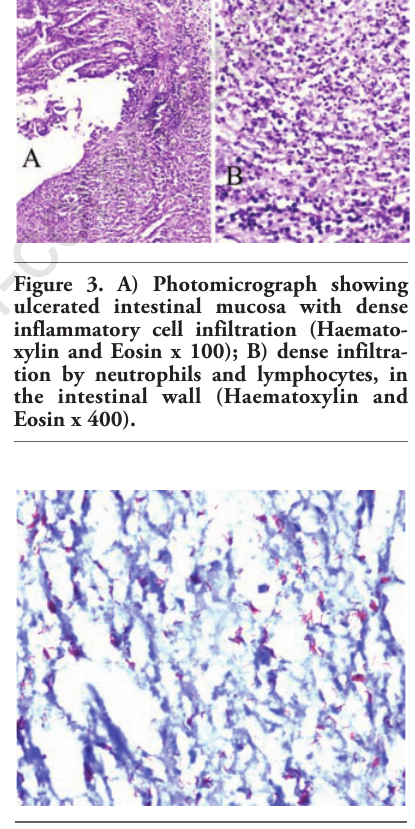
Figure 4. Photomicrograph showing strong positivity for acid fast bacilli (Ziehl- Neelsen stain x